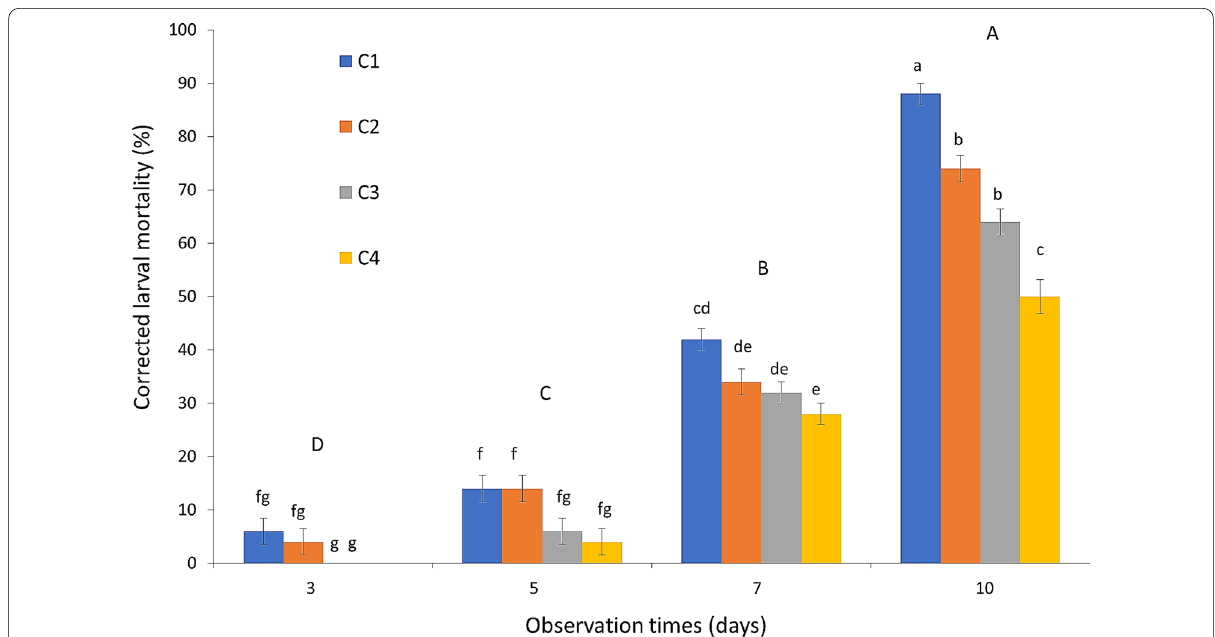
Fig. 4 Percent corrected mortality of 3 rd instar larvae of fall armyworm Spodoptera frugiperda bioassayed against different concentrations of indigenously isolated strain of entomopathogenic fungus Metarhizium anisopliae under laboratory conditions. Concentrations C1–C4 correspond to 1.0 10 6 –1.0 10 9 conidia/ml. Small letters at bar tops indicate significant difference among the concentrations, while capital letters indicate × × overall significant difference among the mortality at different time intervals (factorial ANOVA followed by Tukey’s HSD test at α